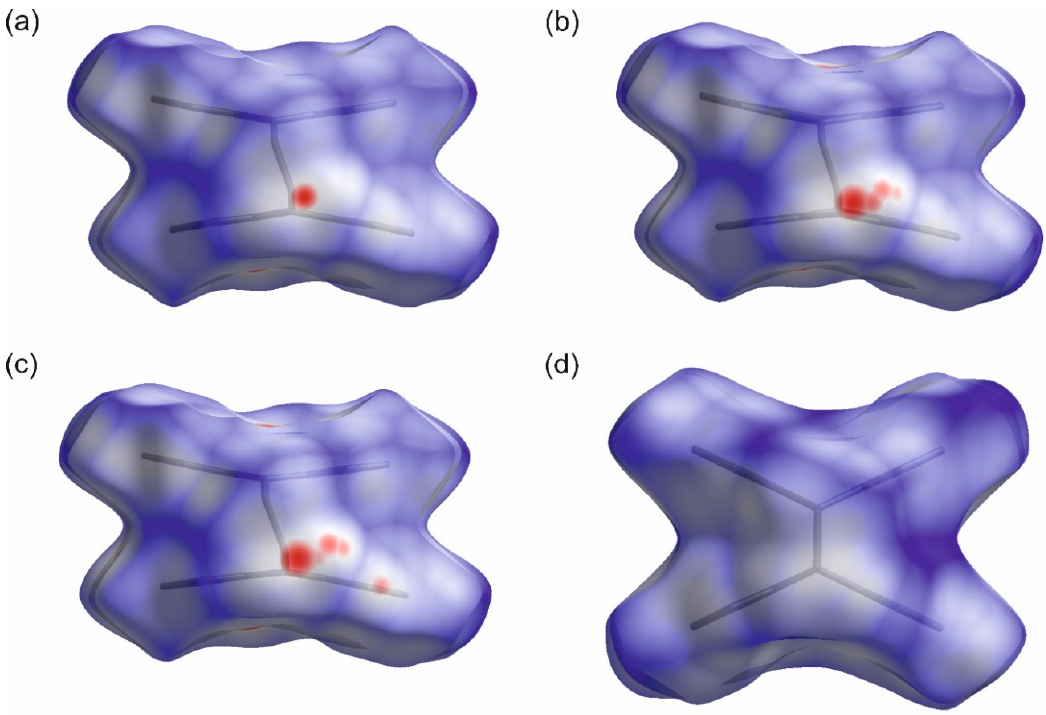
Figure 3. The Hirshfeld surfaces [27,28] for the reactant molecule at ( a ) 0.1 MPa, ( b ) 0.3 GPa, ( c ) 1.0 GPa and for ( d ) the product molecule at 0.1 MPa. The data for the preparation of parts ( a ) and ( d ) were taken from [5]. The molecular skeletons seen inside the surfaces reveal the differences in the “butterfly” angles (see the text).